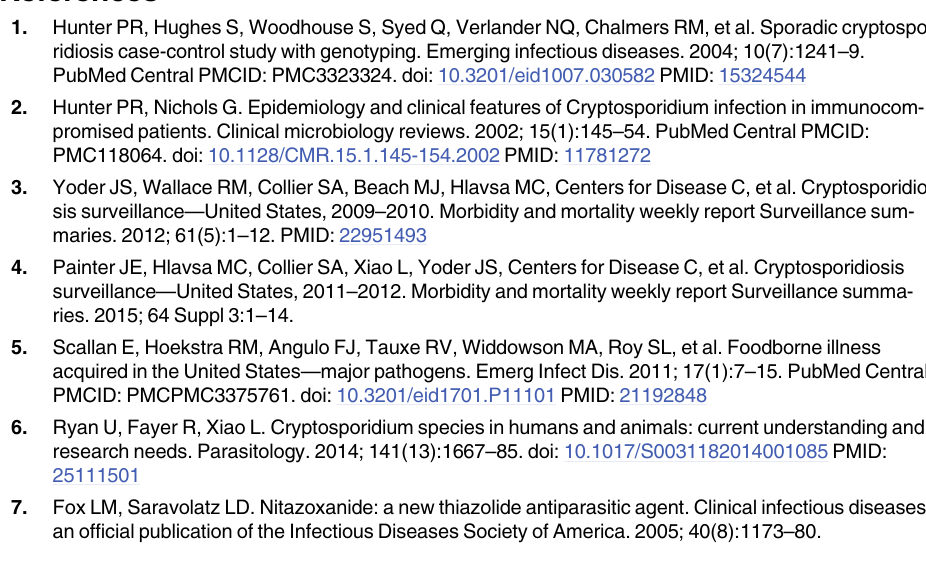
S1 Table. Giardia and Cryptosporidium Rapid Cartridge Assay Guidelines for Laborator-